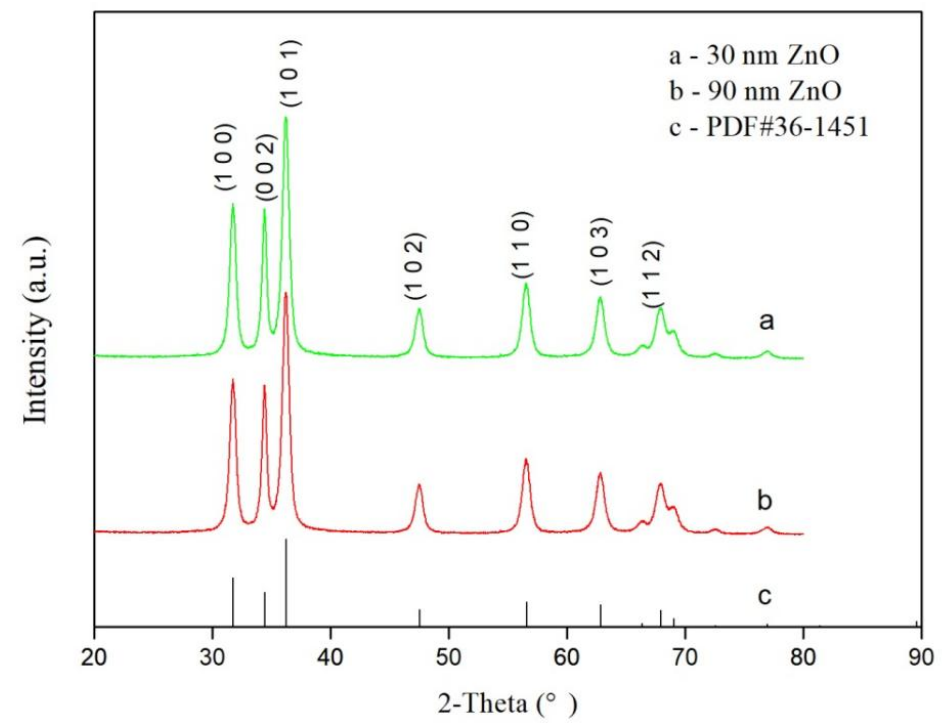
Figure 6. X-ray diffraction (XRD) patterns of nano-ZnO of two sizes.